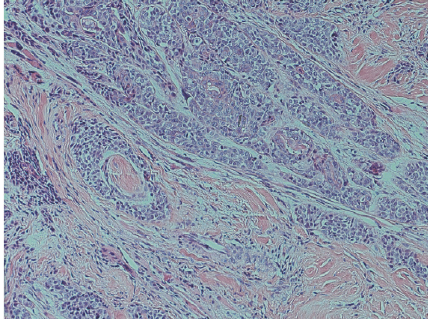
Figure 3: H&E stain demonstrating perineural invasion of the